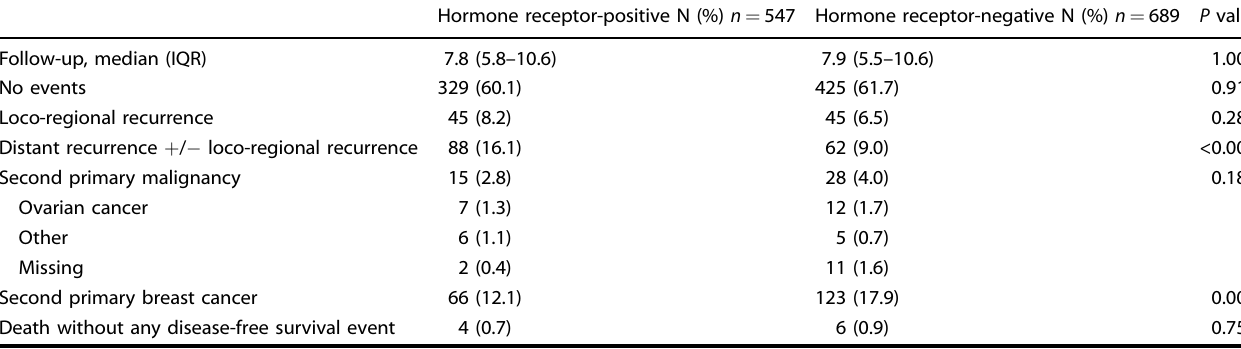
Table 3. Pattern of invasive disease-free survival events according to hormone receptor